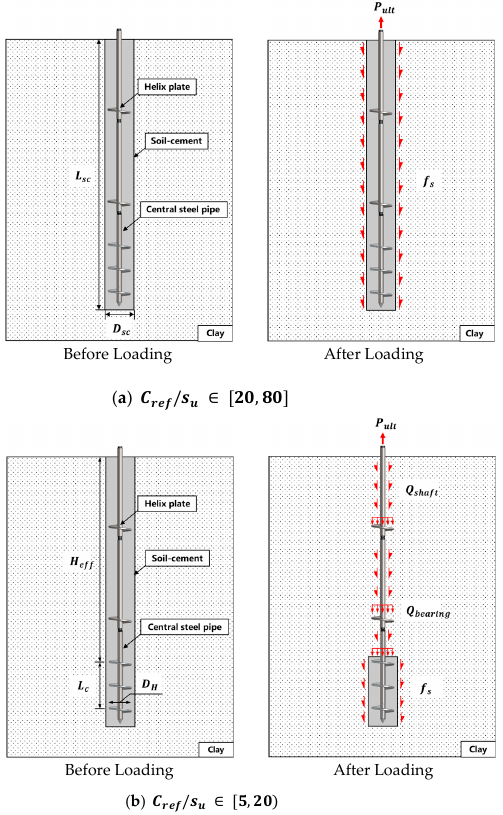
Figure 10. Diagram of the theoretical calculation model .